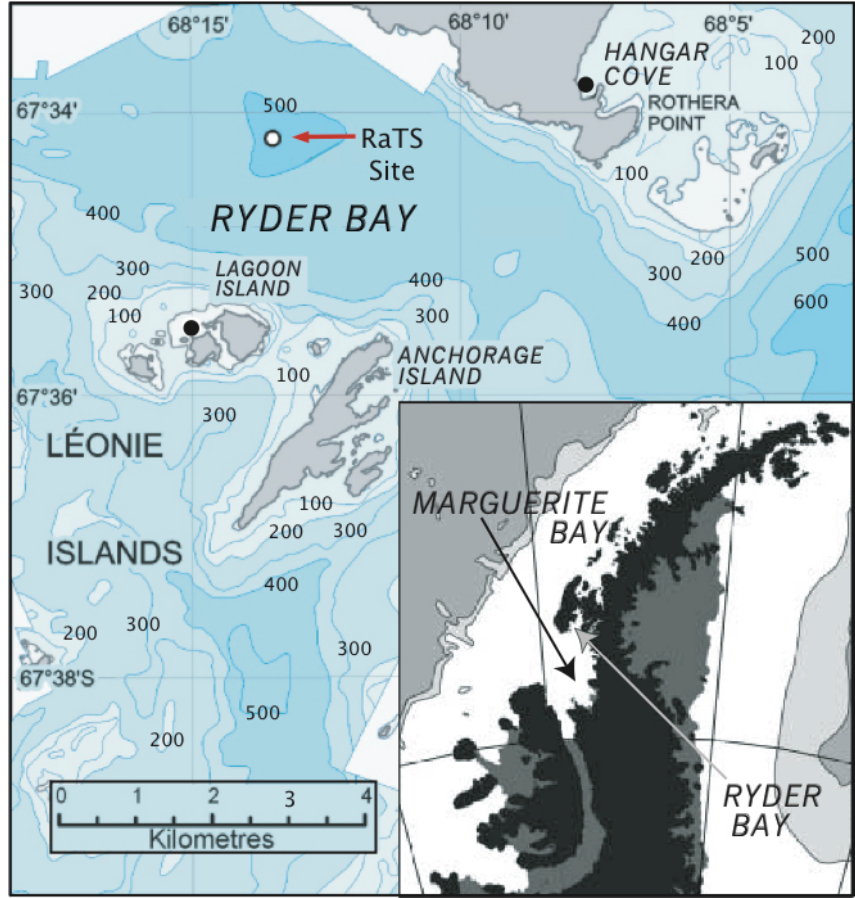
Fig. 1. Map of Ryder Bay showing the RaTS site, Hangar Cove and Lagoon Island sampling stations. Map courtesy of the British Antarctic Survey. Inset shows position of Ryder Bay on the western Antarctic Peninsula. After Clarke et al. (2007,